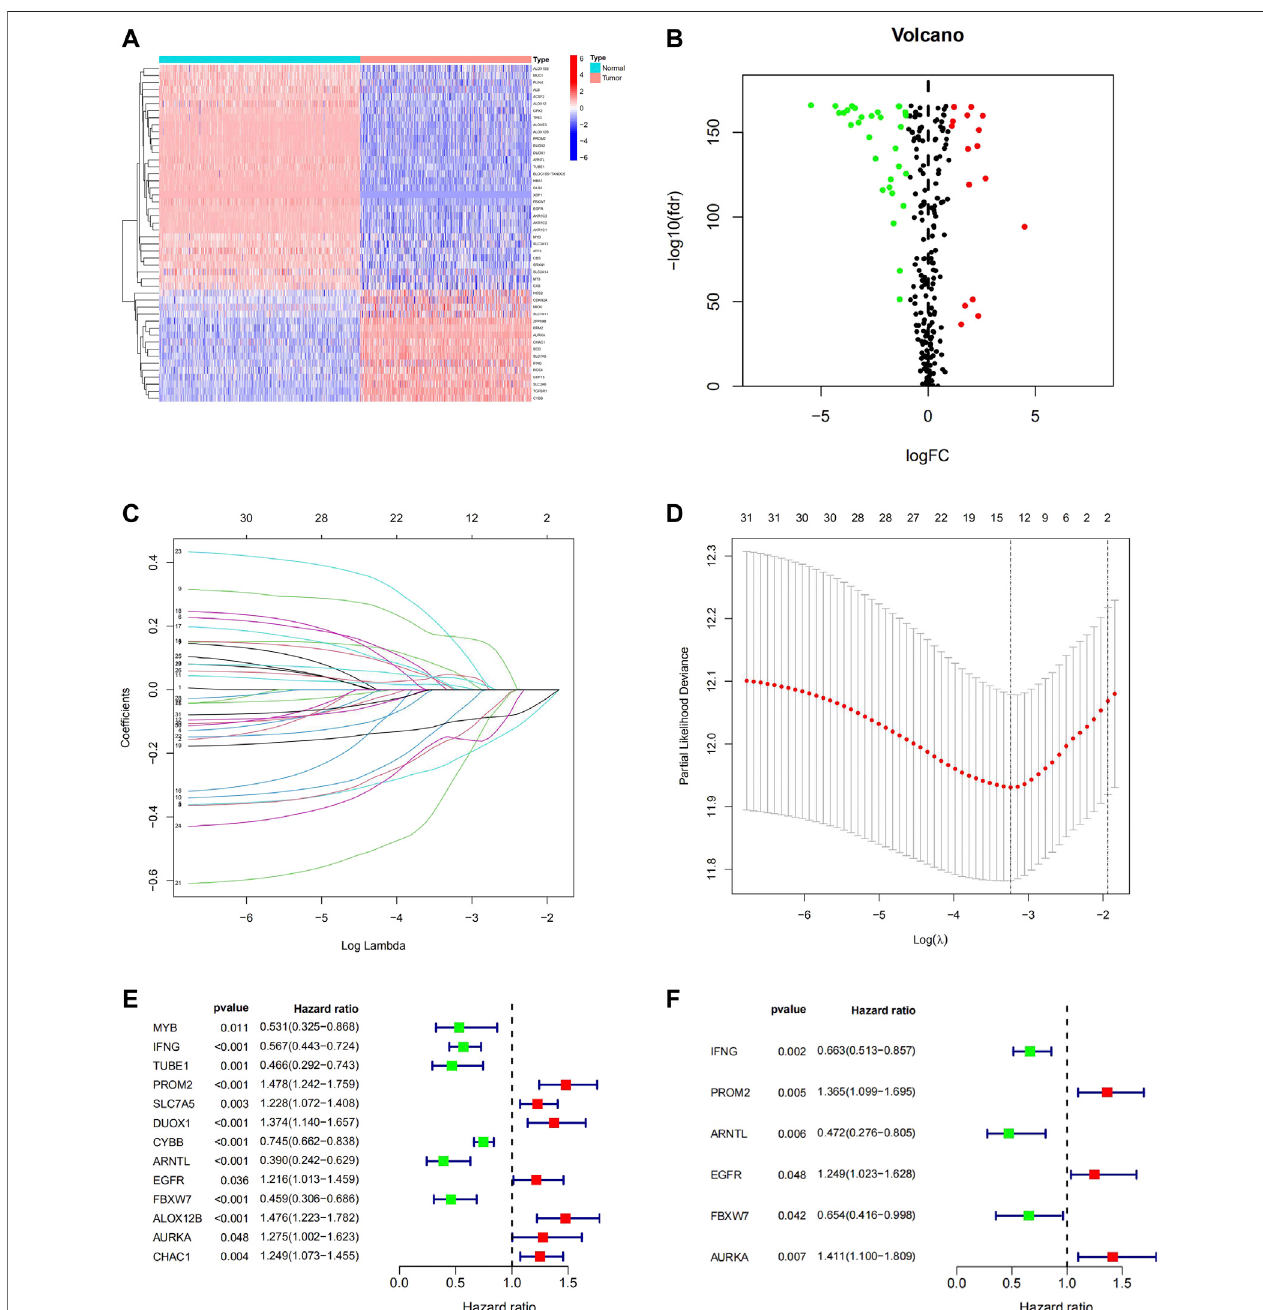
FIGURE 2 | Identi fi cation of Ferroptosis-Related Prognostic gene signature in the TCGA Cohort. The 48 DEGs between the normal skin tissues and melanoma tissues in TCGA were displayed in the heatmap (A) and volcano map (B) . LASSO coef fi cient spectrum of 48 genes in melanoma (C) . Cross-validation for tuning parameter selection in the proportional hazards model (D) . 13 prognostic Genes were discovered in univariate cox analysis (E) and 6-FRGs signature was identi fi ed via multivariate Cox analysis (F) .